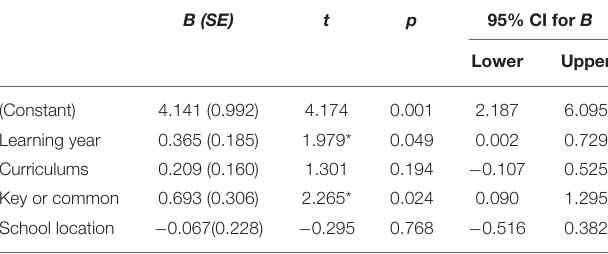
TABLE 2 | Predictors of